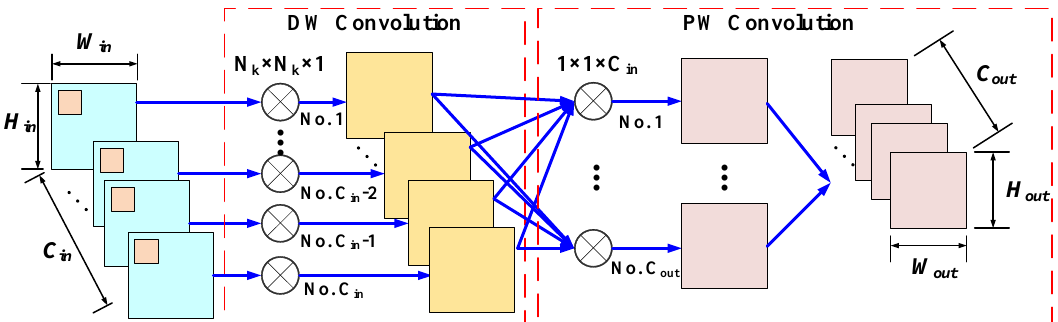
Figure 3. The convolution procedure of the depth-wise (DW) separable convolution (SeConv) layer that decomposes the standard convolution into two steps: the DW convolution and the point-wise (PW) convolution. During the DW convolution process, each channel of the 𝑊 𝑖𝑛 × 𝐻 𝑖𝑛 × 𝐶 𝑖𝑛 feature map, 𝐹 𝑖𝑛 , is convolved with a filter the size of 𝑁 𝑘 × 𝑁 𝑘 × 1 to generate an intermediate feature map that has 𝐶 𝑖𝑛 channels. Subsequently, 𝐶 𝑜𝑢𝑡 PW filters with the size 1 × 1 × 𝐶 𝑖𝑛 are adopted to combine the output of the depth-wise layer and produce the final output feature map, 𝐹 𝑜𝑢𝑡 , with the size of 𝑊 𝑜𝑢𝑡 × 𝐻 𝑜𝑢𝑡 × 𝐶 𝑜𝑢𝑡 .